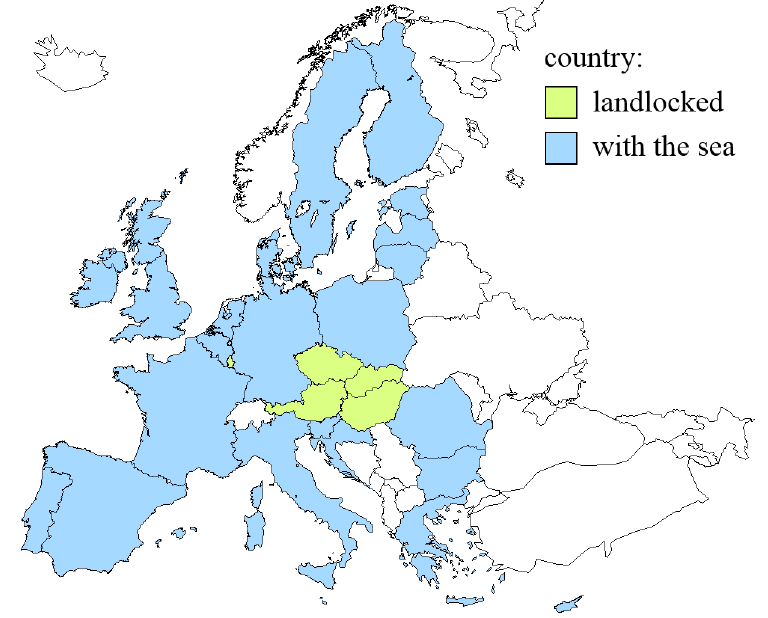
Figure 2. European Union countries with access to the sea. Source: prepared by the author. Europe has a highly complex and varied coastline. The islands represent approx. 7.5%, and peninsulas approx. 25% of the continent surface area (own study based on [40]). It is surrounded by